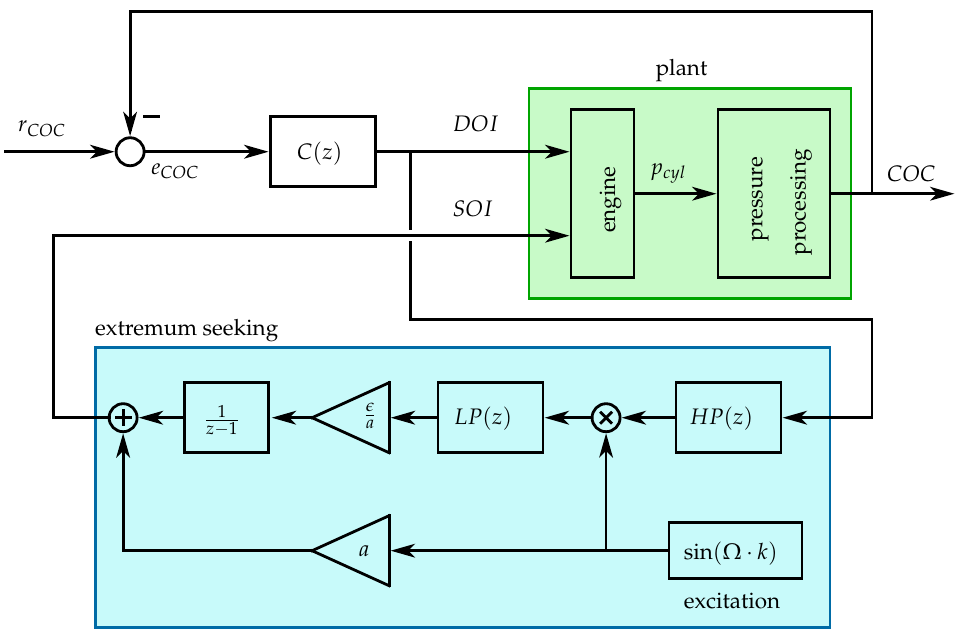
Figure 8. Diesel-minimal combustion control structure of the slow excitation approach: slow excitation on the start of injection SOI . The duration of injection DOI is fed to the extremum seeking